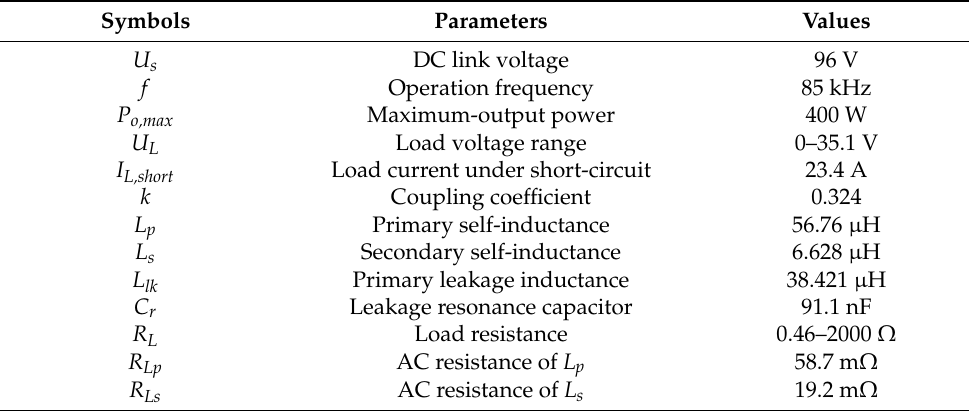
Figure 3. Conventional resonance design in the SS topology: ( a ) voltage gain for different load resistances; ( b ) phase angle for different load resistances. Table 1. Measured parameters of the proposed IPT